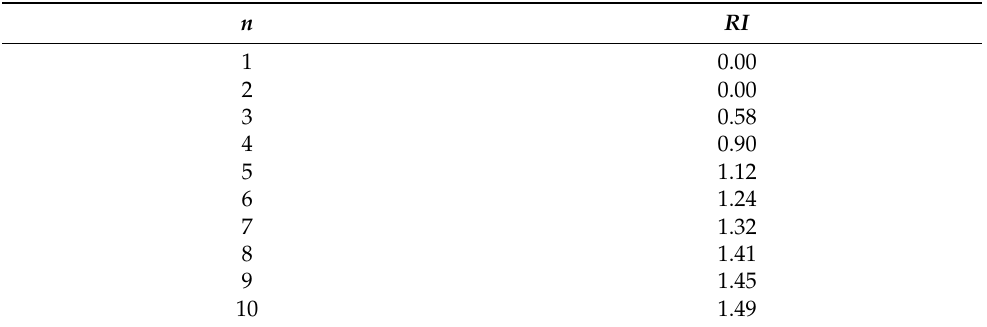
Table 2. Random index RI